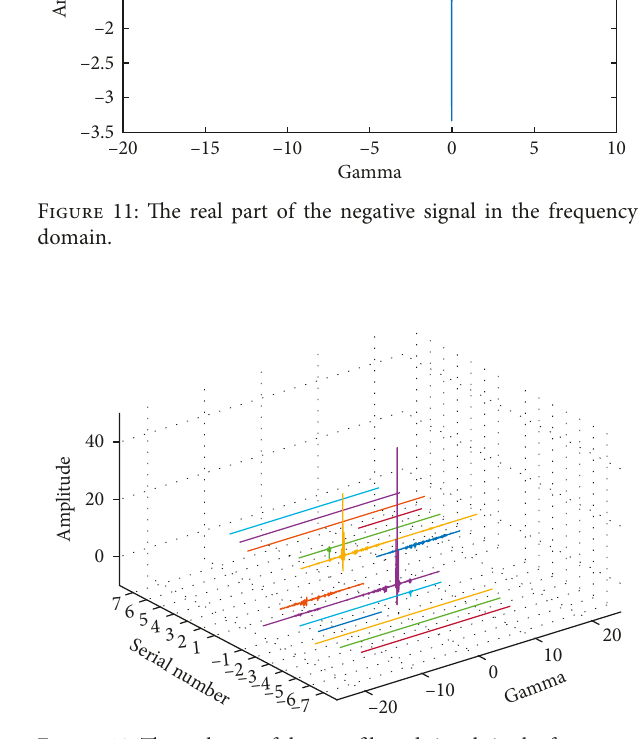
Figure 12: The real part of the new filtered signals in the frequency